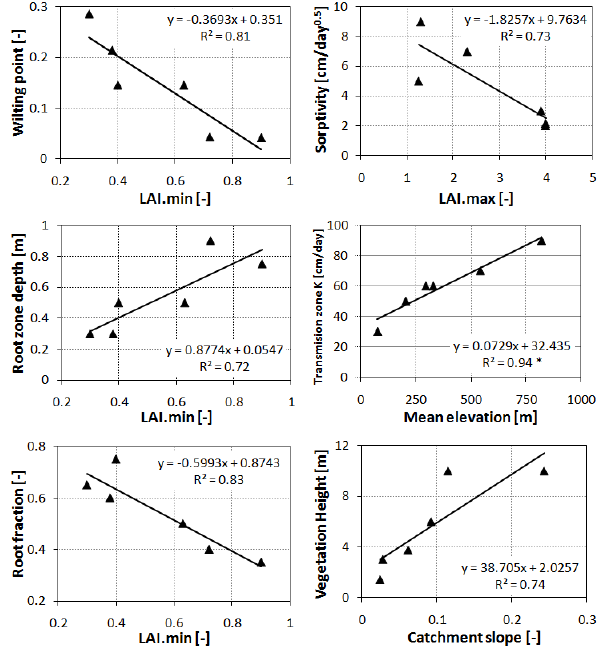
Figure 7 : Observed and simulated regime curves of monthly precipitation, evapotranspiration and Fig. 7. Observed and simulated regime curves of monthly precipita- discharge. Potential evapotranspiration is computed from the model using minimal stomatal tion, evapotranspiration and discharge. Potential evapotranspiration resistance. – Left = San Marcos,TX – Right = Amite, LA – Vertical lines are ± one standard deviation. is computed from the model using minimal stomatal resistance. – Left panel=San Marcos, TX – Right panel=Amite, LA – Vertical lines are ± 1 standard deviation.